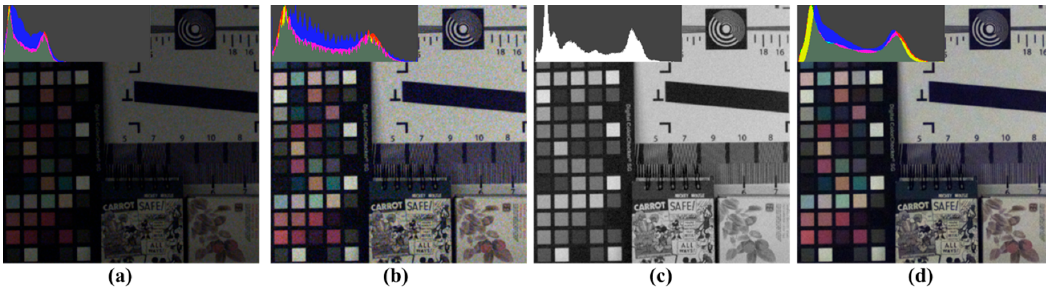
Figure 13. Change in sensitivity depending on the process under a low-light condition: ( a ) RGB channels of Sony RGBW CFA demosaicing results before applying gain [24]; ( b ) RGB channels of Sony RGBW CFA demosaicing results after applying gain [24]; ( c ) W channel of Sony RGBW CFA demosaicing results [24]; ( d ) proposed method post-processing results.